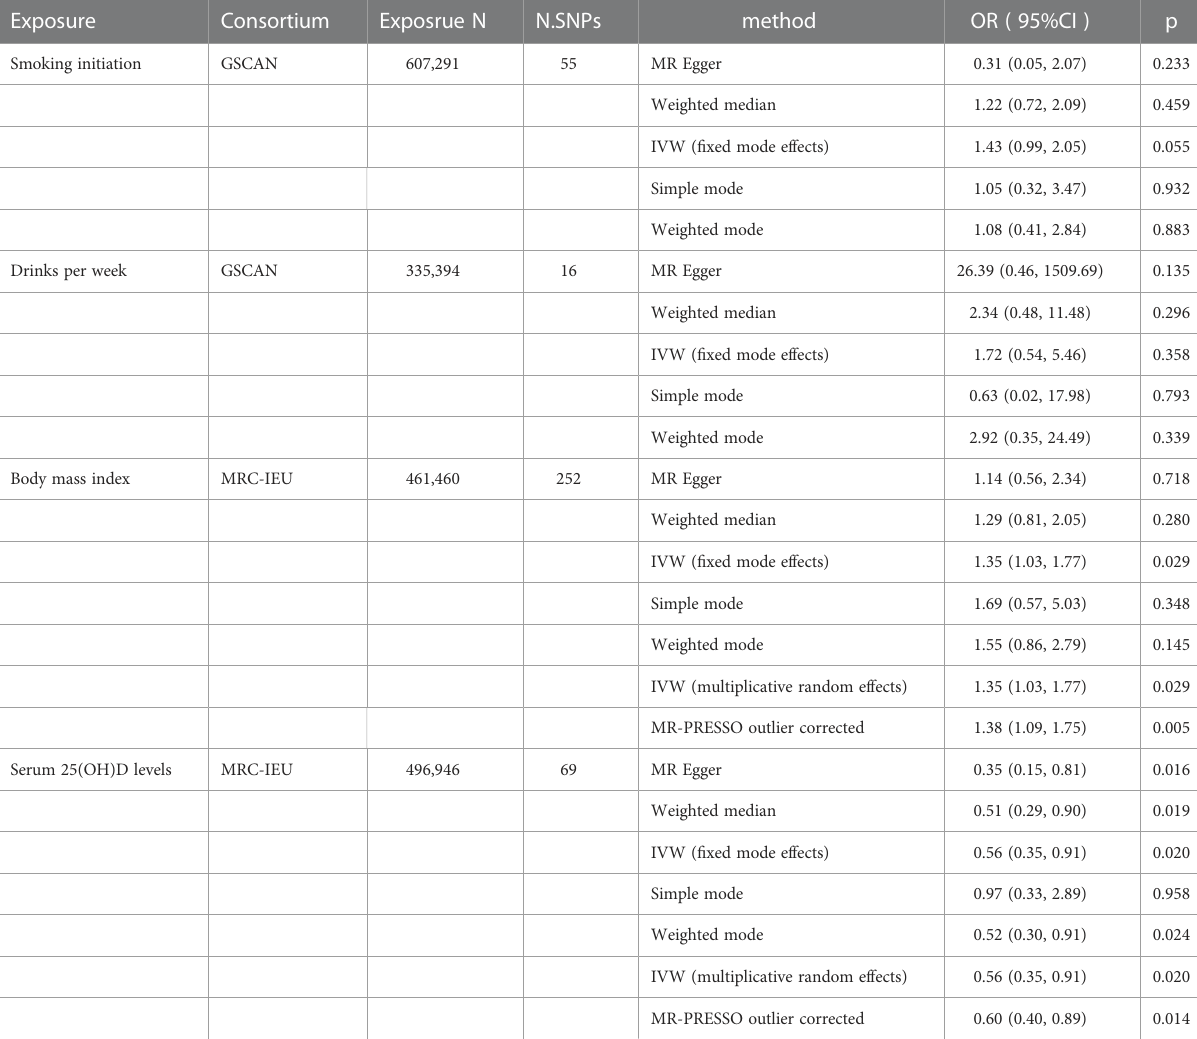
TABLE 1 Univariable Mendelian randomization of exposures on the risk for